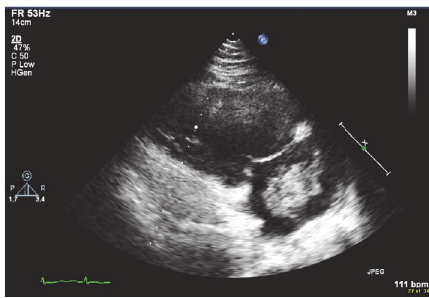
Figure 2: CT pulmonary angiogram revealed a saddle embolus extending into the main, lobar, and segmental pulmonary arterial branches bilaterally with massive clot burden and near complete occlusion of the right main and branch pulmonary arteries.